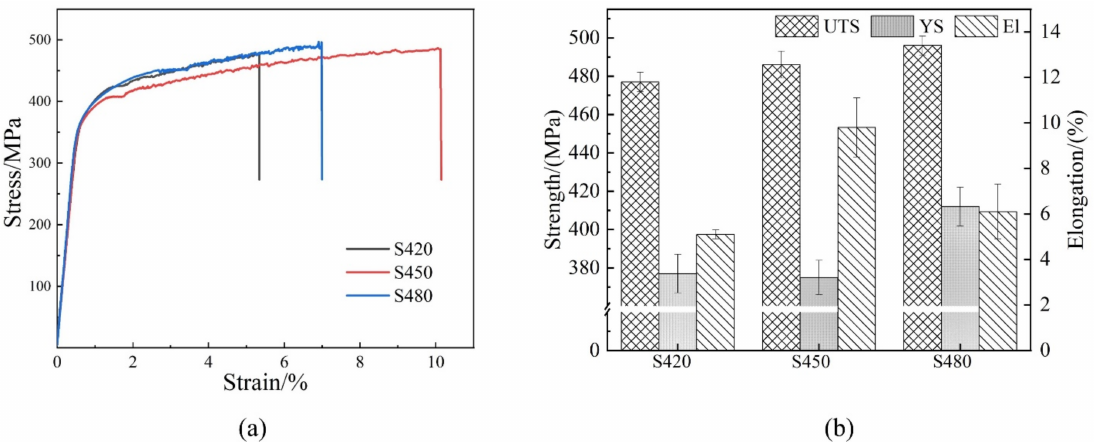
Figure 12. Room-temperature mechanical properties of samples at different rolling temperatures after aging treatment: stress–strain curve ( a ), comparison of ultimate tensile strength, yield strength, and elongation ( b